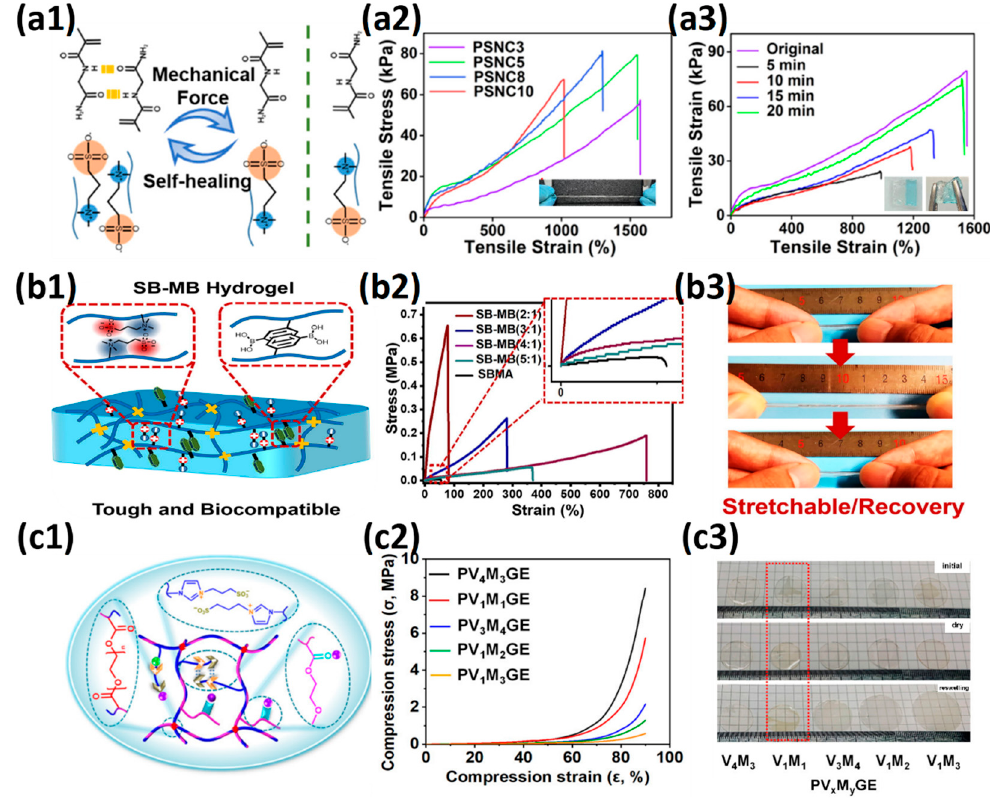
Figure 5. Mechanical strengthening of zwitterionic hydrogels prepared by copolymerization: ( a1 – a3 ) zwitterionic hydrogel was prepared with NAGA as a copolymerization component. The dipole– dipole interaction between zwitterionic units and the hydrogen bond interaction between NAGA units synergistically promote the mechanical properties and self-healing ability of hydrogels ( a1 ), leading to stretchable, tough ( a2 ) and rapid self-healing ( a3 ). Reproduced with permission from [99]. Copyright 2021, American Chemical Society; ( b1 – b3 ) zwitterionic hydrogel prepared with MPBA as a copolymerization component. The aromatic ring of phenylboronic acid provided additional π – π stacking ( b1 ). The introduction of the MPBA component improved both the toughness and modulus of zwitterionic hydrogels ( b2 ) and also enabled the hydrogels to exhibit good recovery ability ( b3 ). Reproduced with permission from [102]. Copyright 2021 Elsevier Inc. All rights reserved; ( c1 – c3 ) zwitterionic hydrogel with oleophilic elastomer pMEA segments ( c1 ). When the weight ratio of zwitterionic VIPS/oleophilic MEA was 1/1, the prepared PV 1 M 1 GE showed 6 MPa at 90% compressive strain ( c2 ) and non-swelling in electrolytes ( c3 ). Reproduced with permission from [33]. Copyright 2021, American Chemical